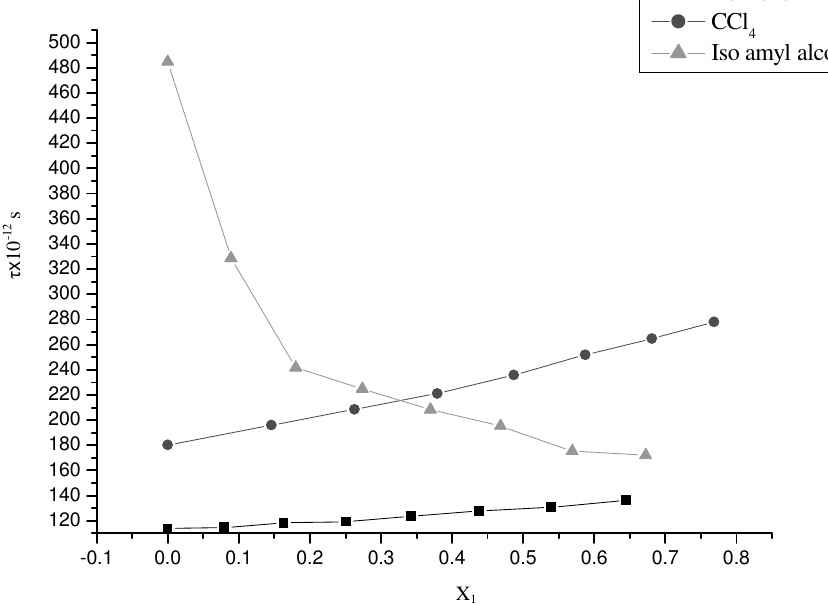
Figure 6. Variation of relaxation time ( τ ), with mole fraction for all the